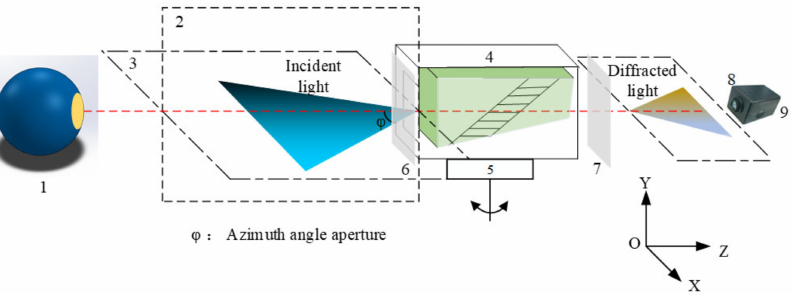
Figure 7. Integrating experimental sphere setup of AOTF based on different incident light an-